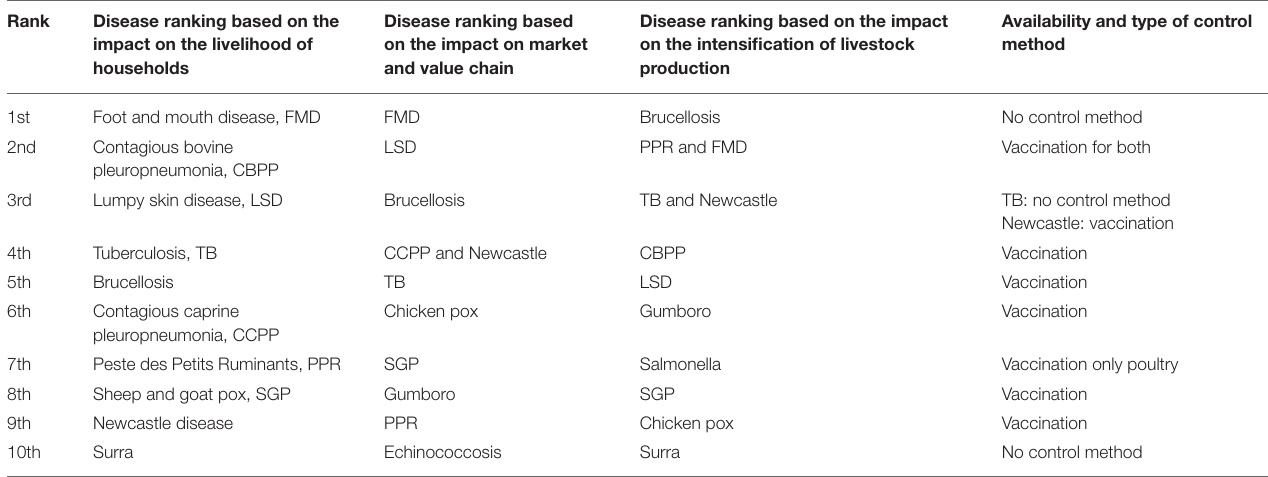
TABLE 1 | The 10 top ranked livestock diseases in Ethiopia in descending order based on the degree of impact on the livelihood of households, market/value chains, and intensification of animal production (15) and their control methods. Rank Disease ranking based on the impact on the livelihood